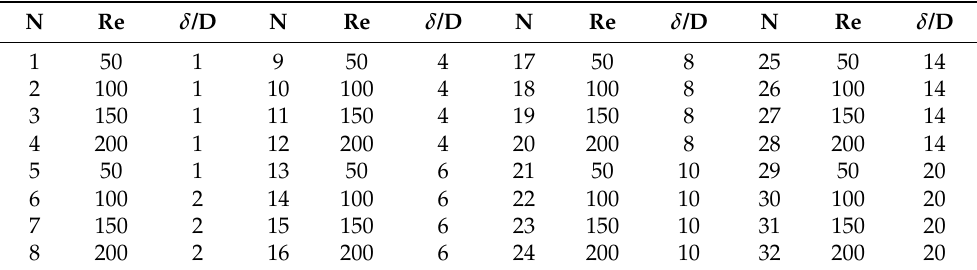
Table 1. List of the 32 computational